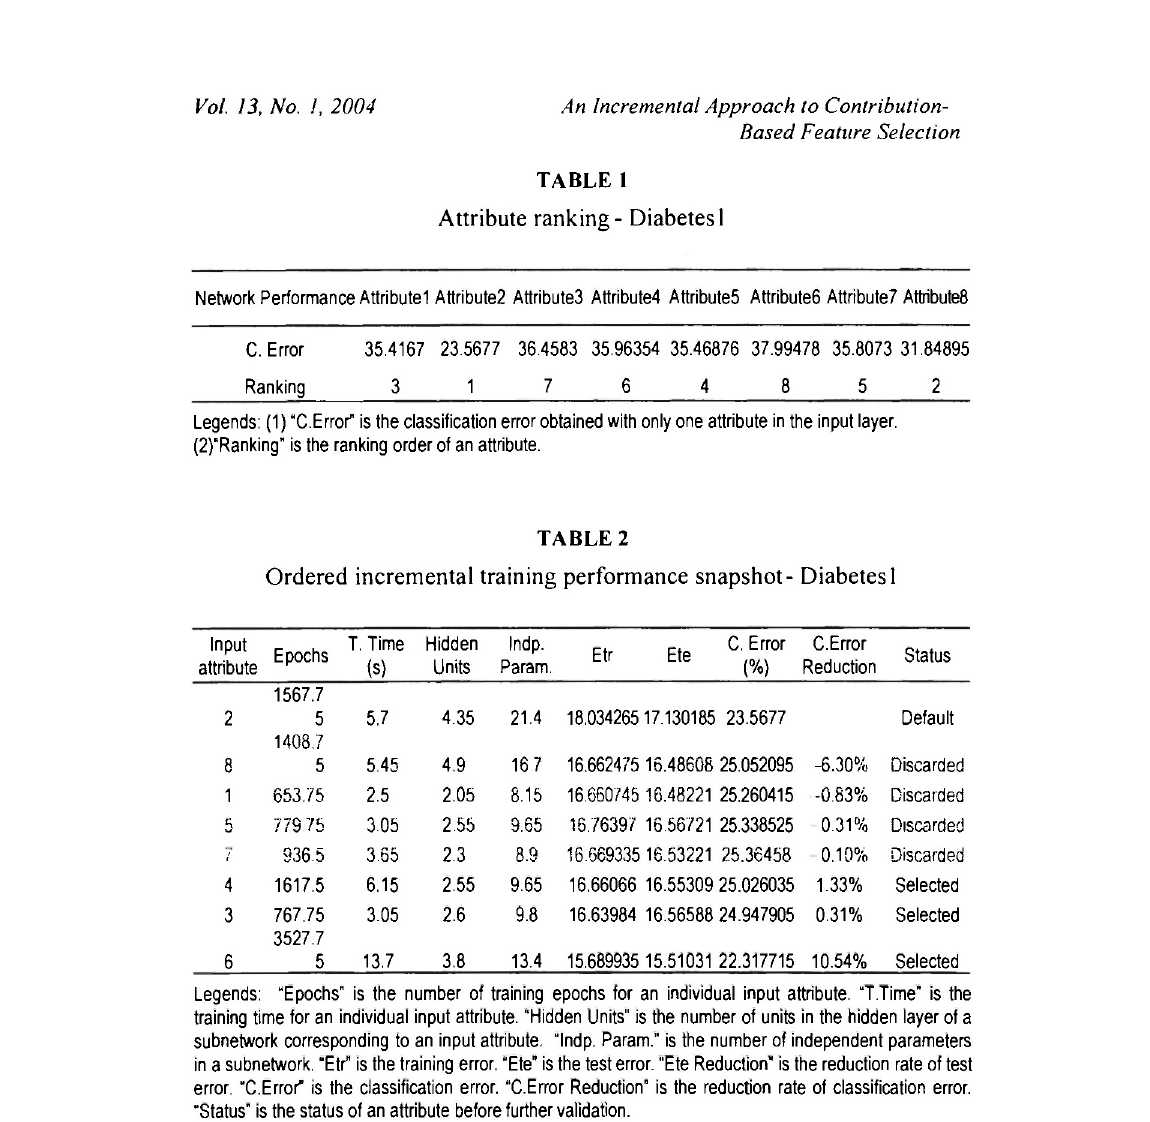
Validation results (Method 1) -